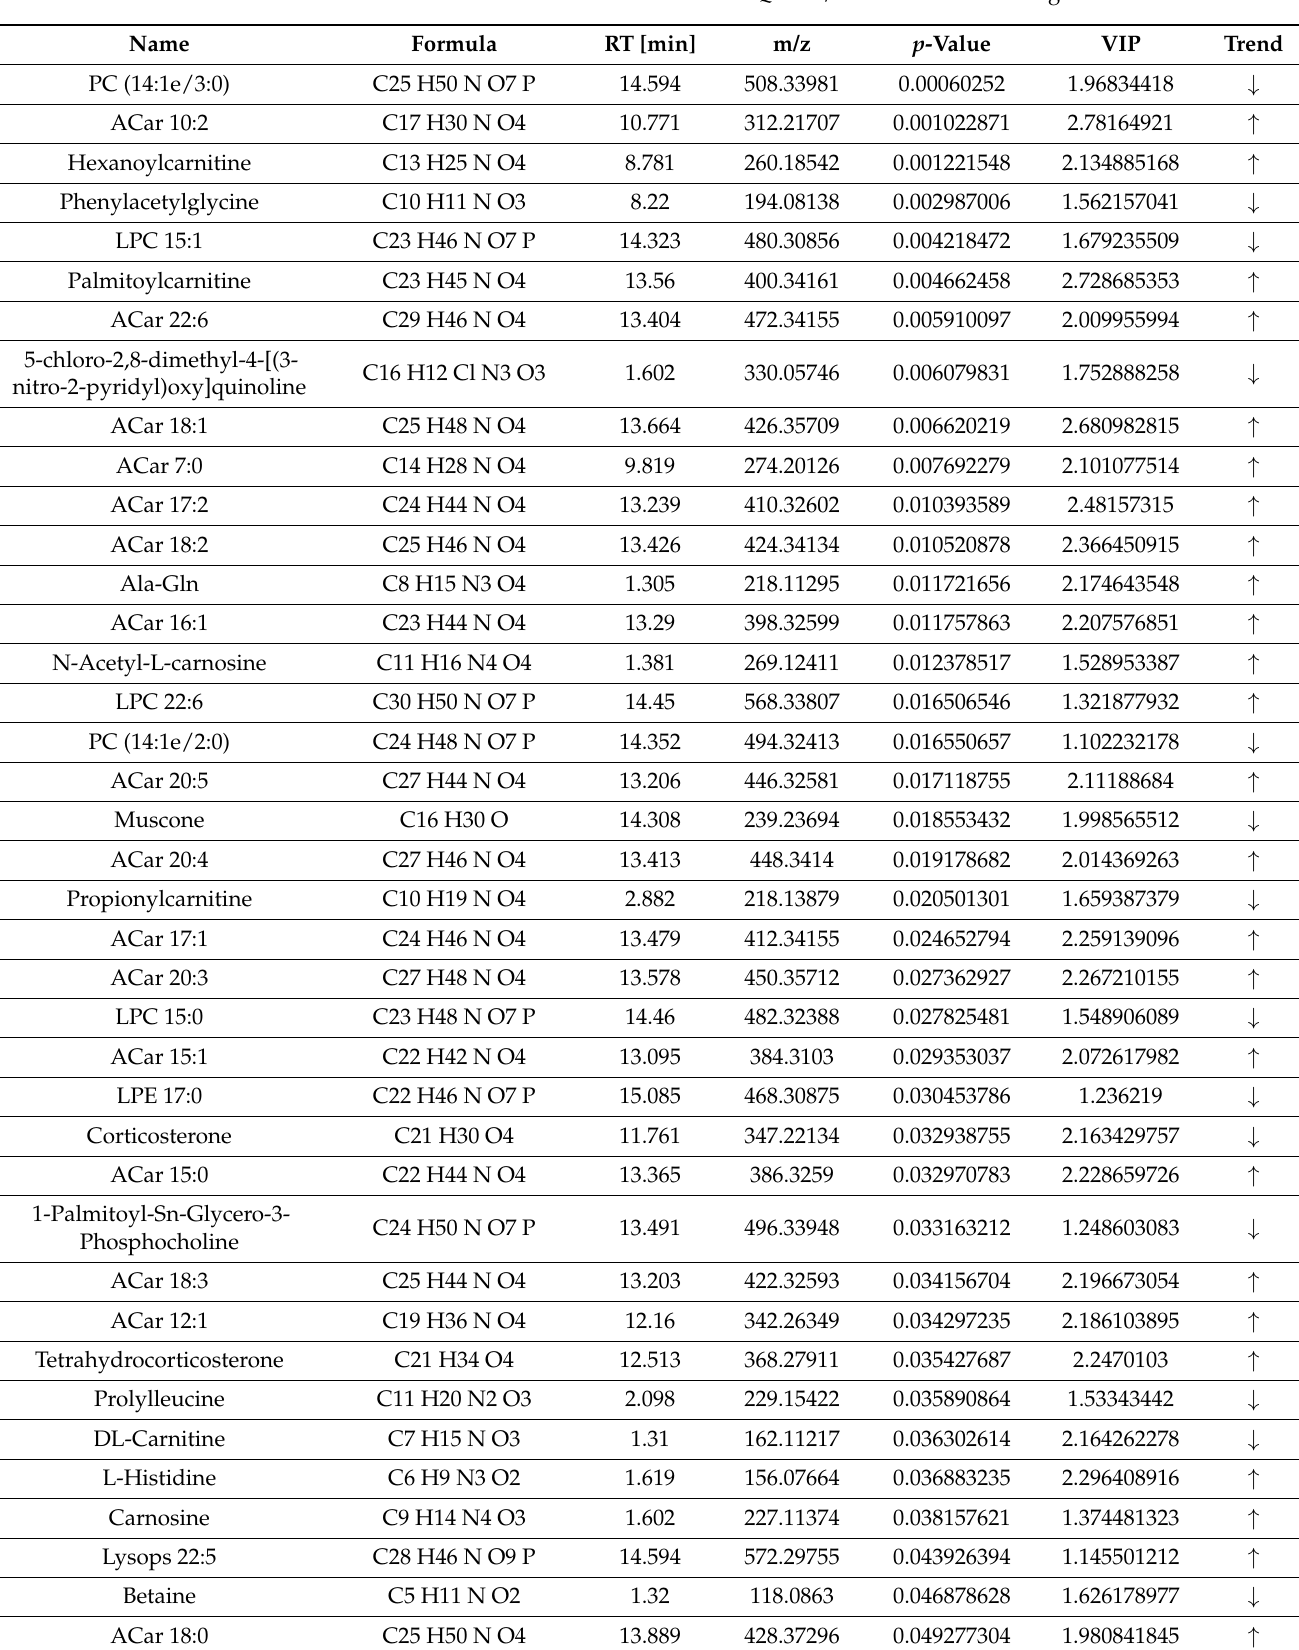
Table 2. Potential skeletal muscle biomarkers based on UPLC-Q-TOF/MS in rabbits fed a high-fat